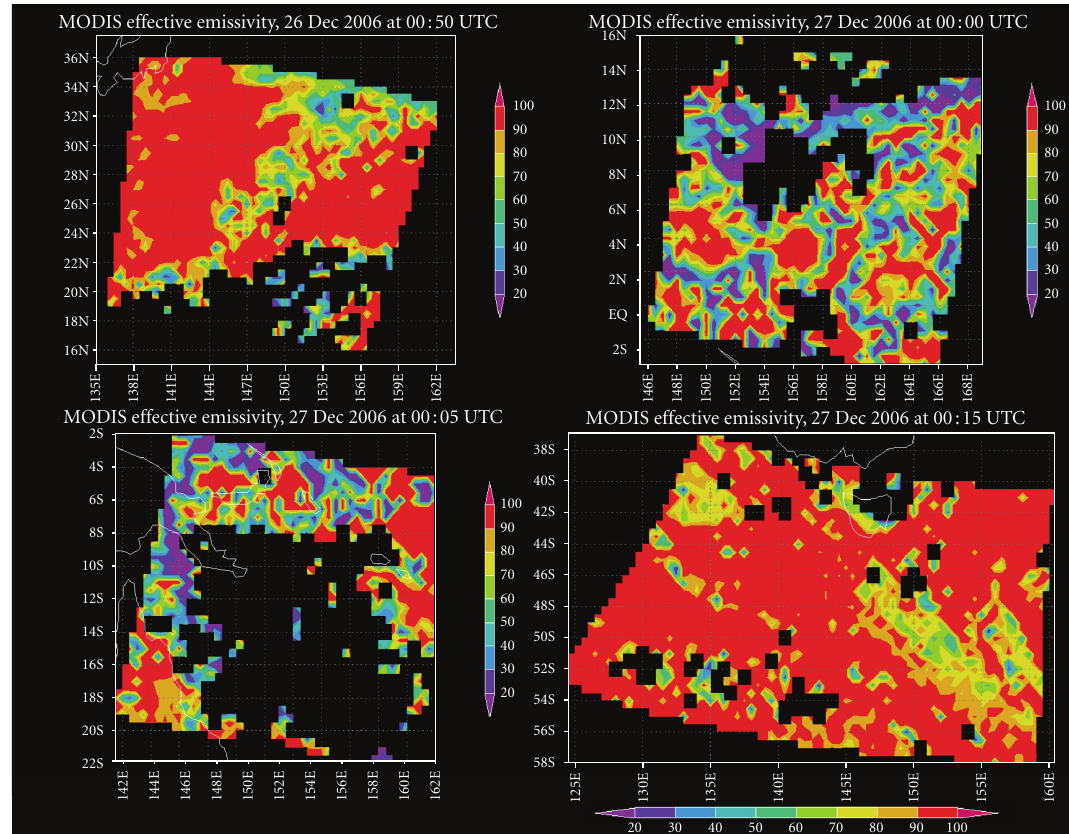
Figure 8: Distribution of the e ff ective emissivity corresponding to similar scenes as those of Figure